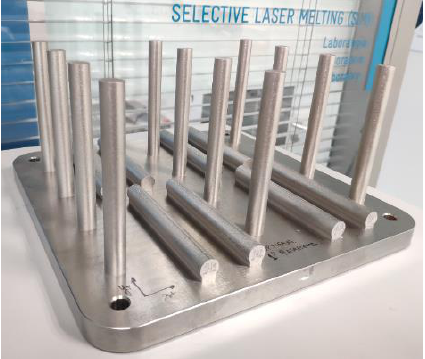
Figure 2. View of cylindrical samples obtained from SLM process. “Z-axis” samples (left, center and on the right of the platform) and “Y-axis” samples (interspersed with vertical specimens).